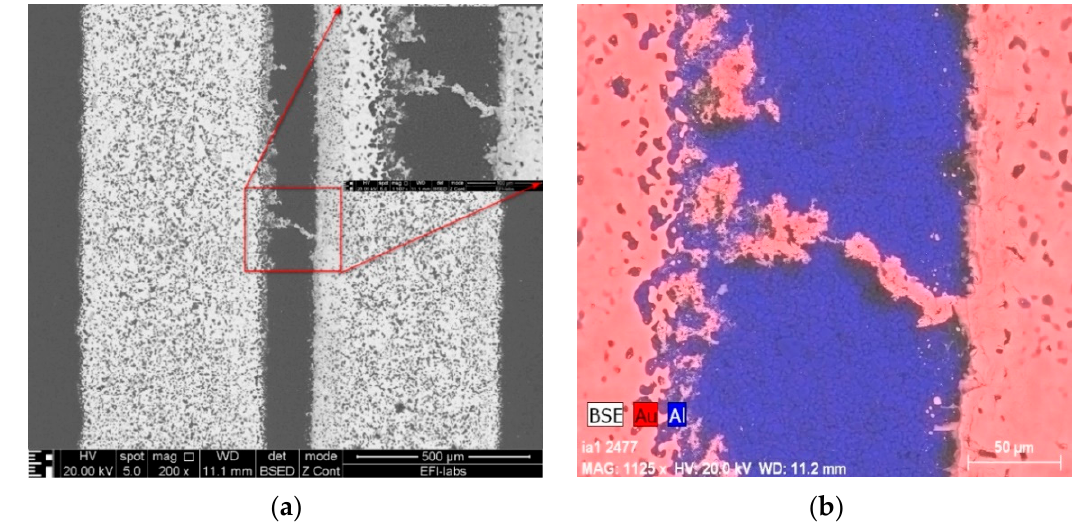
Figure 6. SEM micrographs of the structure shown in Figure 4: ( a ) backscattered electron micrograph; ( b ) backscattered electron micrograph with a color overlay of the elemental distribution by X-ray mapping (Au red, Al blue), (with 10 V bias).